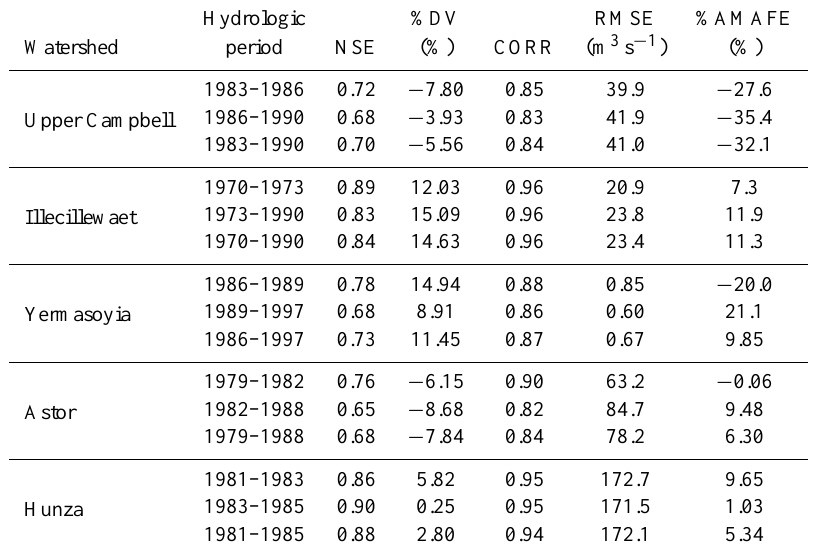
Table 4. Statistical indices of streamflow simulation with the proposed methodology for ungauged watersheds – UBCREG method. Hydrologic %DV RMSE %AMAFE Watershed period